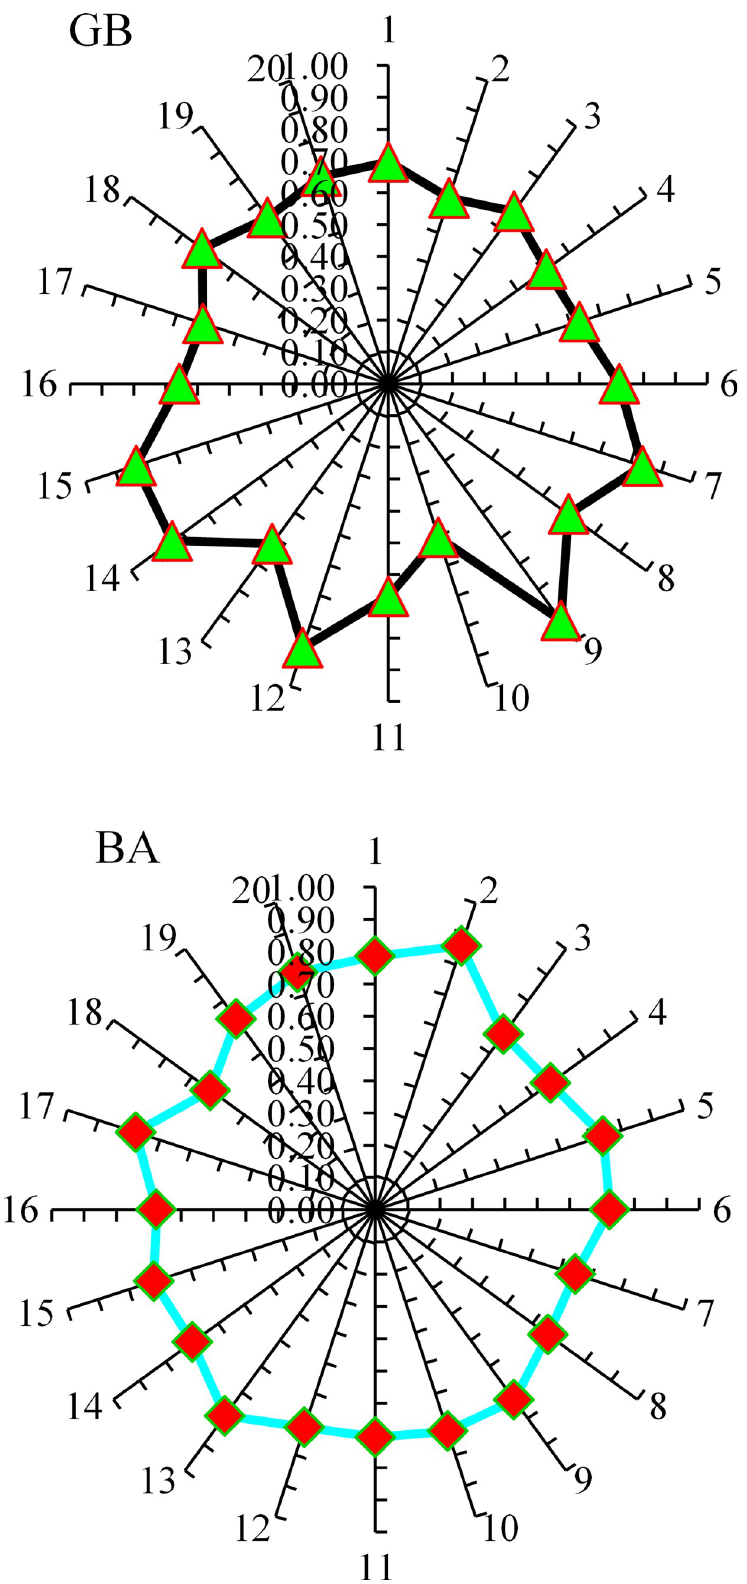
Fig 18. Sub-model results for flowability: (a) GB; (b) BA.